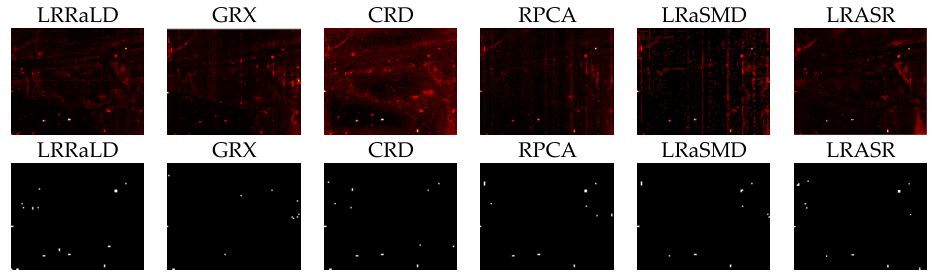
Figure 16. Detection results of HYDICE data set: ( top ) 2-D display; and ( bottom ) binary results when PFA equals 0.001.